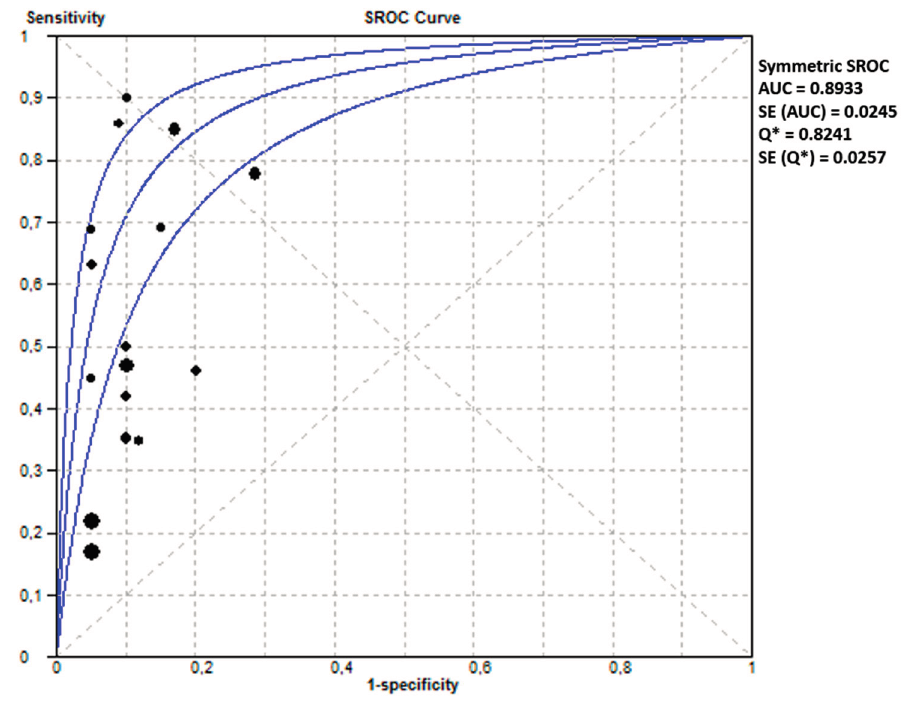
Figure 7. Summary of receiver operating characteristics curve of combination model of laboratory and makers in PE (both EOPE and